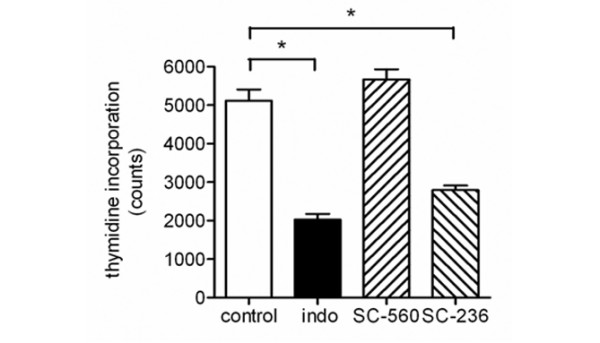
Proliferation assay with selective and unselective cyclooxygenase (COX) inhibitors. The effect of selective and unselective COX inhibitors on chondrocyte proliferation was assessed by [3H]-thymidine incorporation. Subconfluent chondrocytes were synchronized in serum-free medium for 24 hours. Medium was renewed and the indicated inhibitors were added for 24 hours: indo, 50 μM indomethacin; SC-560, 10 μM; SC-236, 10 μM. Data are given as mean ± standard error of the mean, n = 6; *p value < 0.05.